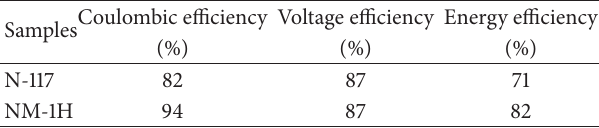
Table 3: The single cell efficiency for VRFB system based on the pristine N-117 membrane and modified NM-1H